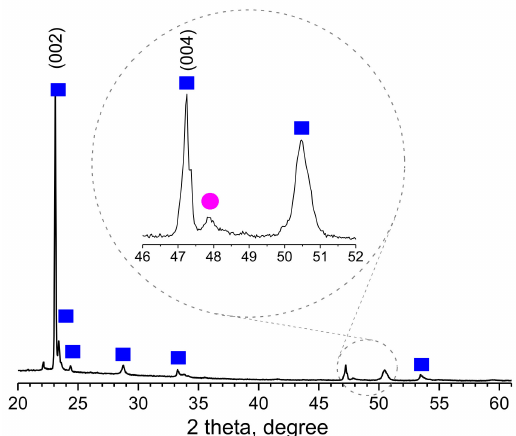
Figure 4. The XRD pattern of the Ce / W films. The diffraction peak at 47.8 ◦ 2 θ (full pink circle) corresponds to cerium dioxide cubic phase (P1), COD ID card no. 7217887, the rest of the diffraction peaks (full blue squares) in the data can be indexed to a monoclinic phase (P21/n), ICDD card no. 72-0677, with only peaks of greatly enhanced intensity (preferred orientation), specifically indexed.